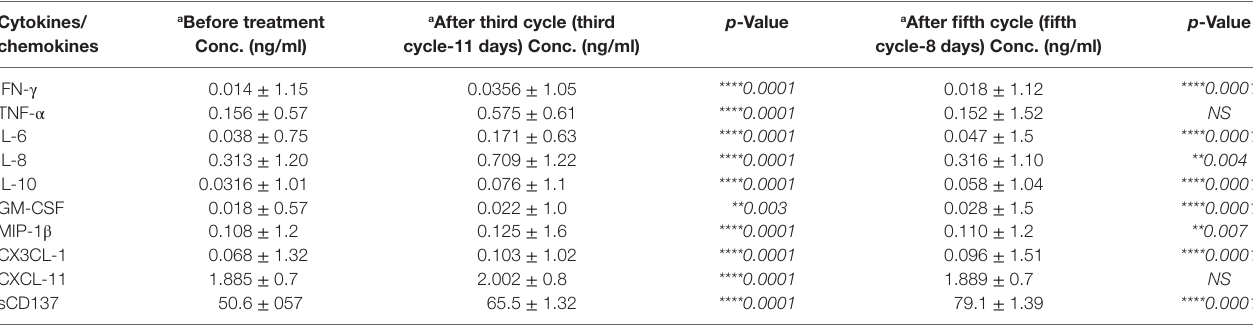
taBle 1 | Plasma concentrations of upregulated cytokines/chemokines after nivolumab treatment. a Before Cytokines/ chemokines